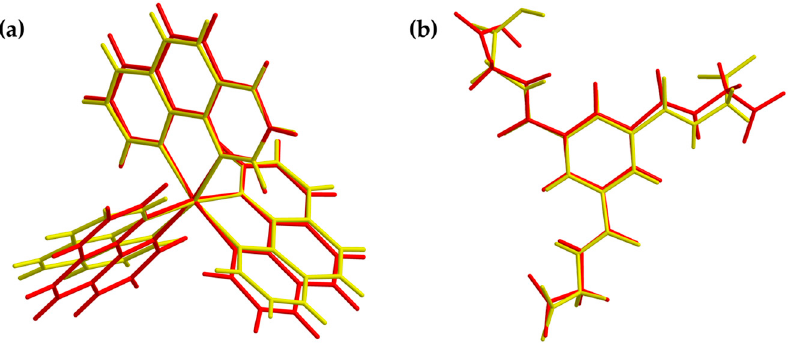
Figure 8. Overlay view of the structures in the crystal (yellow) and optimized structures (red) of the cationic complex ( a ) and the dianion ( b ). Optimization based on BP86/def2-TZVPP (cation) and BP86/ma-def2-TZVPP (anion) level of theory, respectively.